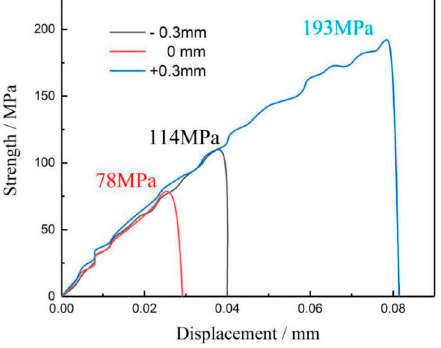
/ TA2 welded joints. Figure 10. Tensile test results of 301L/TA2 welded joints. Figure 10. Tensile test results of 301L Figure 10. Tensile test results of 301L/TA2 welded joints.